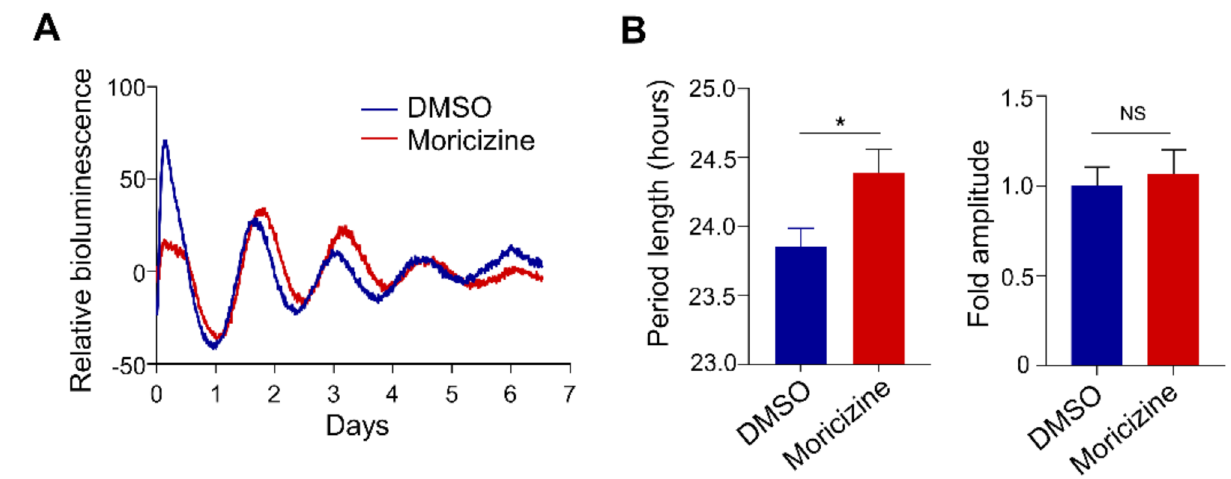
Figure 4. Moricizine lengthens the circadian period in atrial tissues ex vivo. ( A ) Representative PER2::LUC bioluminescence recordings of atrial tissues from Per2::Luc mice (blue traces for DMSO, red traces for 30 µ M moricizine-treated atrial tissues, N = 10-11 for each group). ( B ) Period comparisons and relative fold amplitudes of DMSO or moricizine treated atrial tissues were calculated by the LM fit (damped sin) method. Data are presented as mean ± SEM. T -test shows significant statistical differences between DMSO and flecainide or moricizine. (*, p <